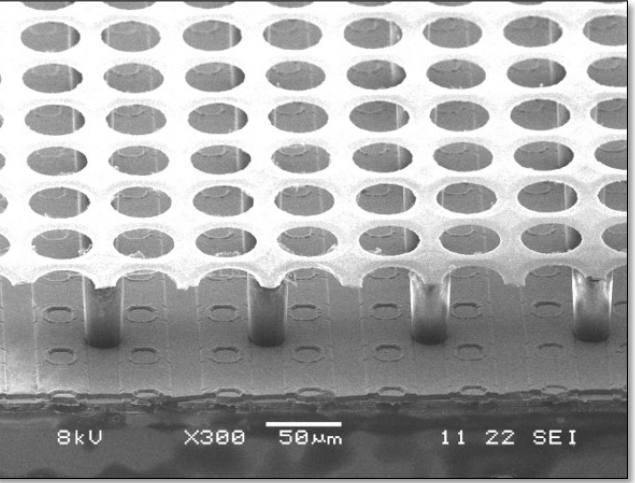
Figure 5. Integrated Micromegas grid (InGrid) on a Timepix